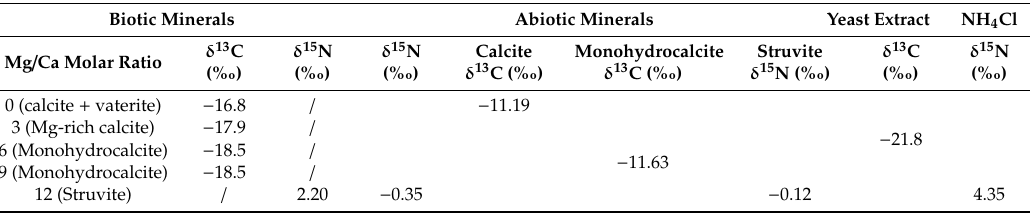
Table 3. Stable carbon and nitrogen isotope values of the biotic and abiotic minerals, yeast extract, and NH 4